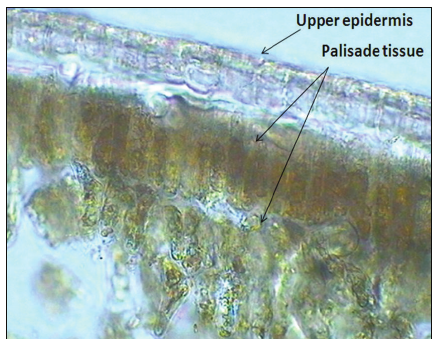
Figure 6: Part of lamina with upper epidermis and palisade tissue (40x).